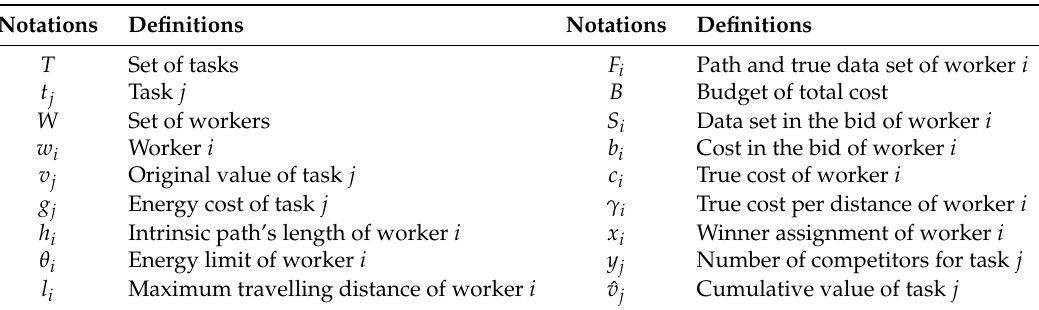
Table 1. Notation definitions.